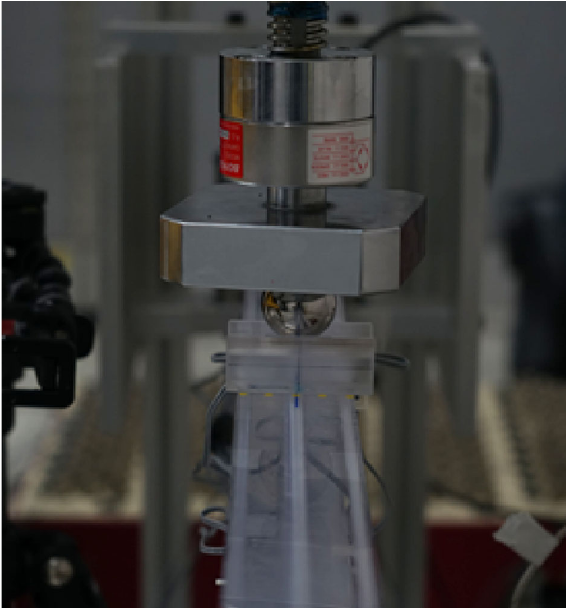
Fig. 4 Loading transfer